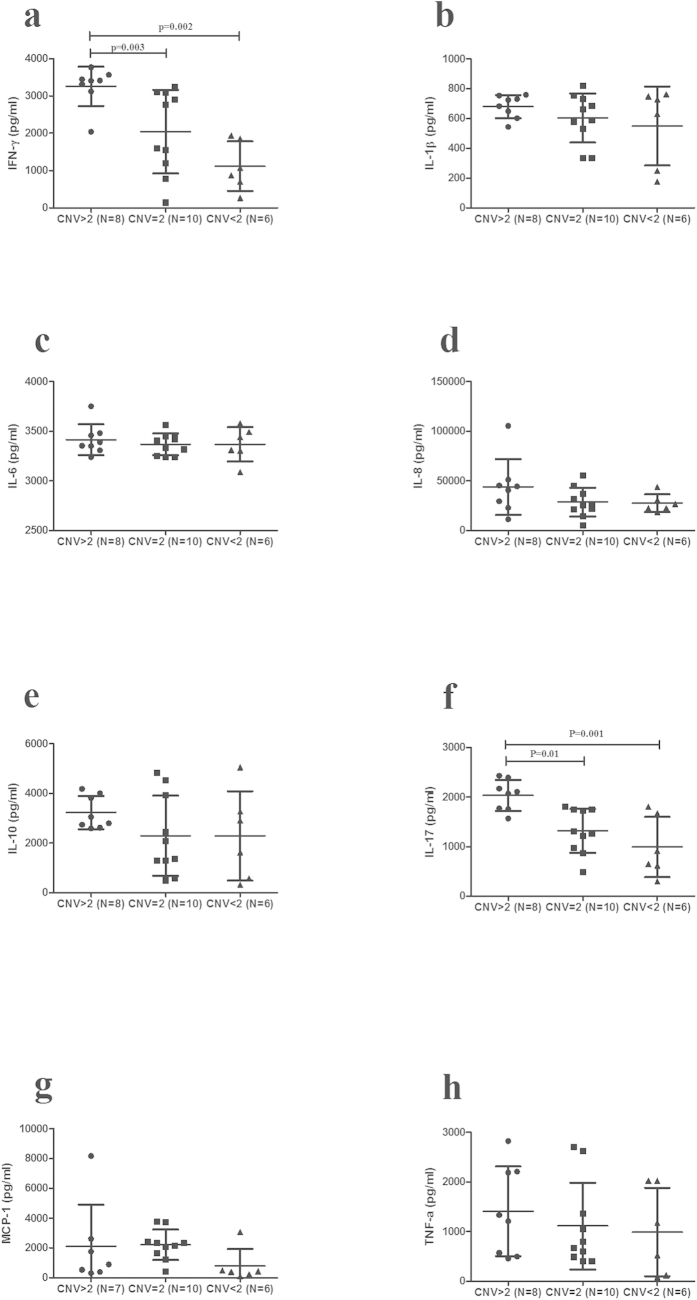
The influence of C3 CNVs on cytokines production.Different copy numbers of C3 on cytokines production. The levels of IFN-γ (a), IL-1β (b), IL-6 (c), IL-8 (d), IL-10 (e), IL-17 (f), MCP-1 (g), and TNF-α (h) in PBMCs from normal controls with different copy numbers of C3 (CNV > 2: n = 7–8, CNV = 2: n = 10, CNV < 2: n = 6). Two independent samples Nonparametric test or one-way ANOVA test was used to analyze the significance. Horizontal line represents the mean level.